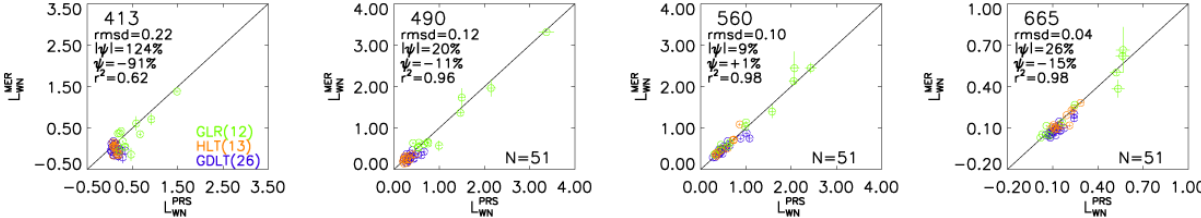
Fig. 3. Scatter plots of MERIS (MER) versus AERONET-OC (PRS) L WN match-ups at selected center wavelengths for different sites with 1t =± 2h. Symbols and units are the same as in Fig. 1. Different colors identify data from different sites (GLR in the Western Black Sea, HLT in the Gulf of Finland, GDLT in the northern Baltic Proper).